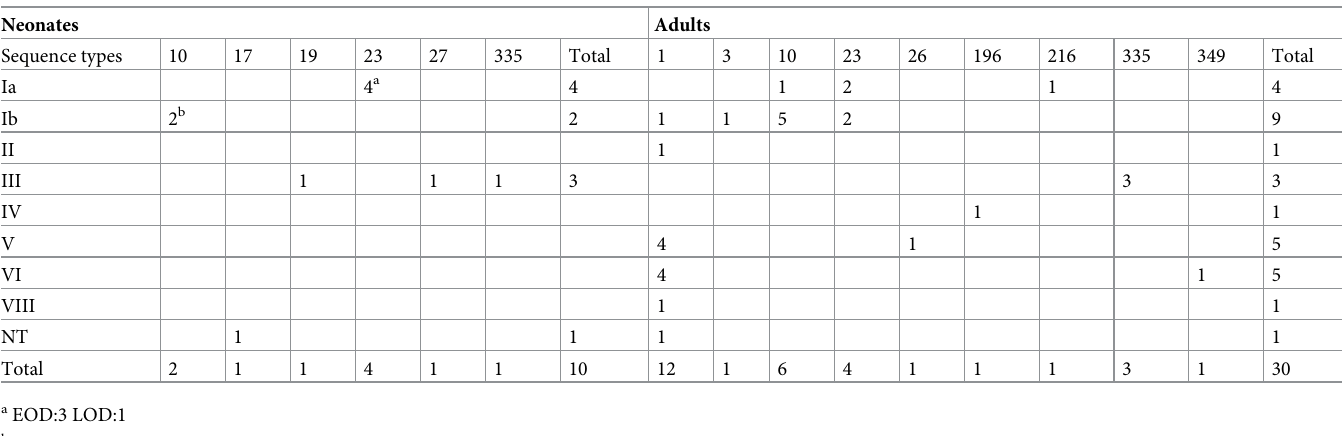
Table 3. Molecular serotypes and MLST among the 40 GBS isolates.